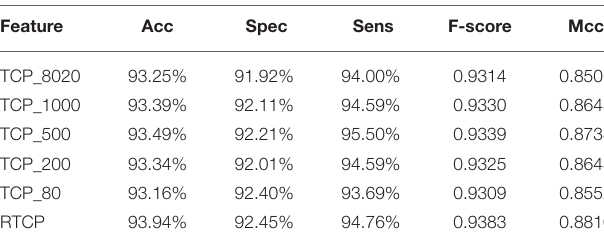
TABLE 4 | Comparison between RTCP based method and TCP based methods.